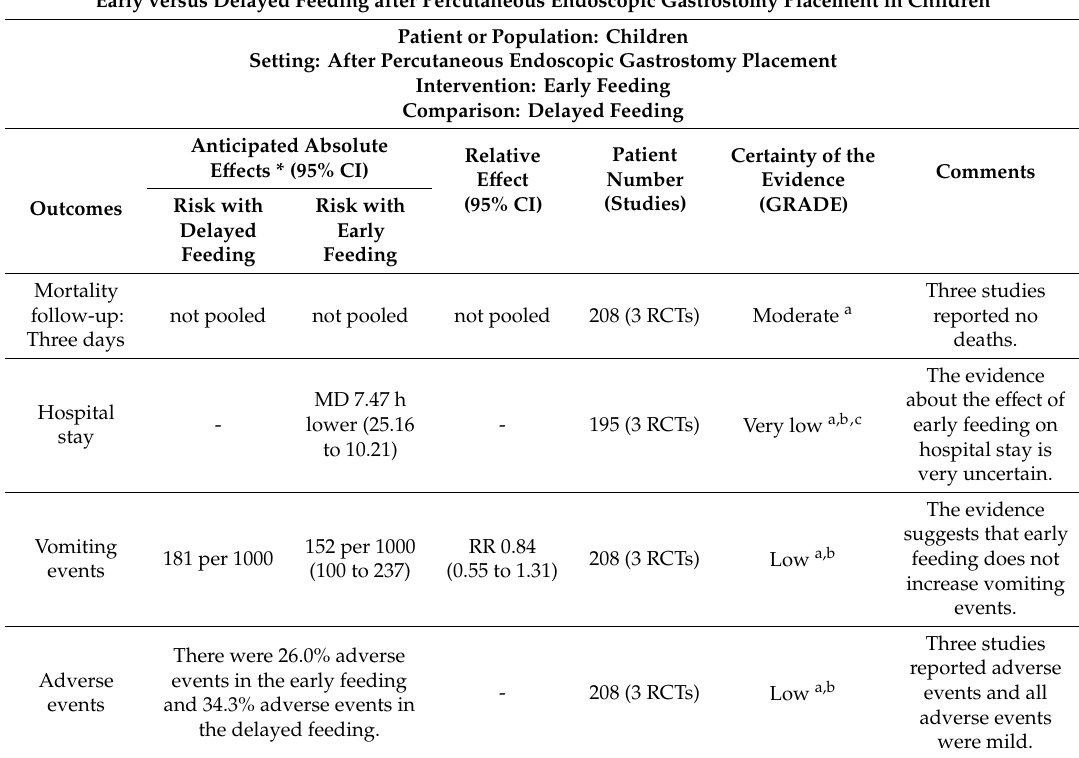
Table 2. Summary of